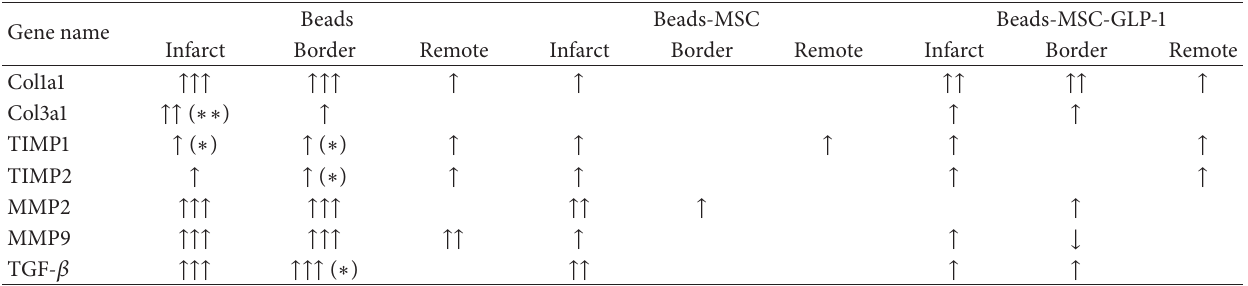
Table 3: Changes in expression levels of genes involved in ECM remodeling four week after MI. Large changes in expression are demonstrated by arrows ( ↑ = 2–20x increase, ↑↑ = 20–50x increase, and ↑↑↑ = > 50x change). Significance is denoted in